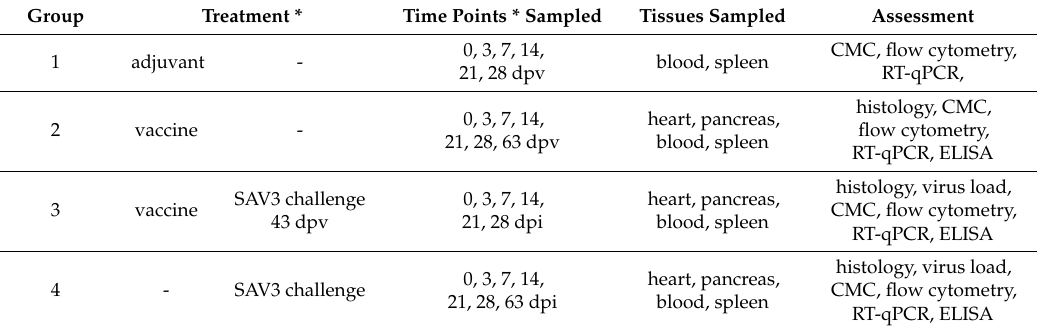
Table 1. Treatment groups examined to compare immune responses after vaccination, challenge, and vaccination followed by